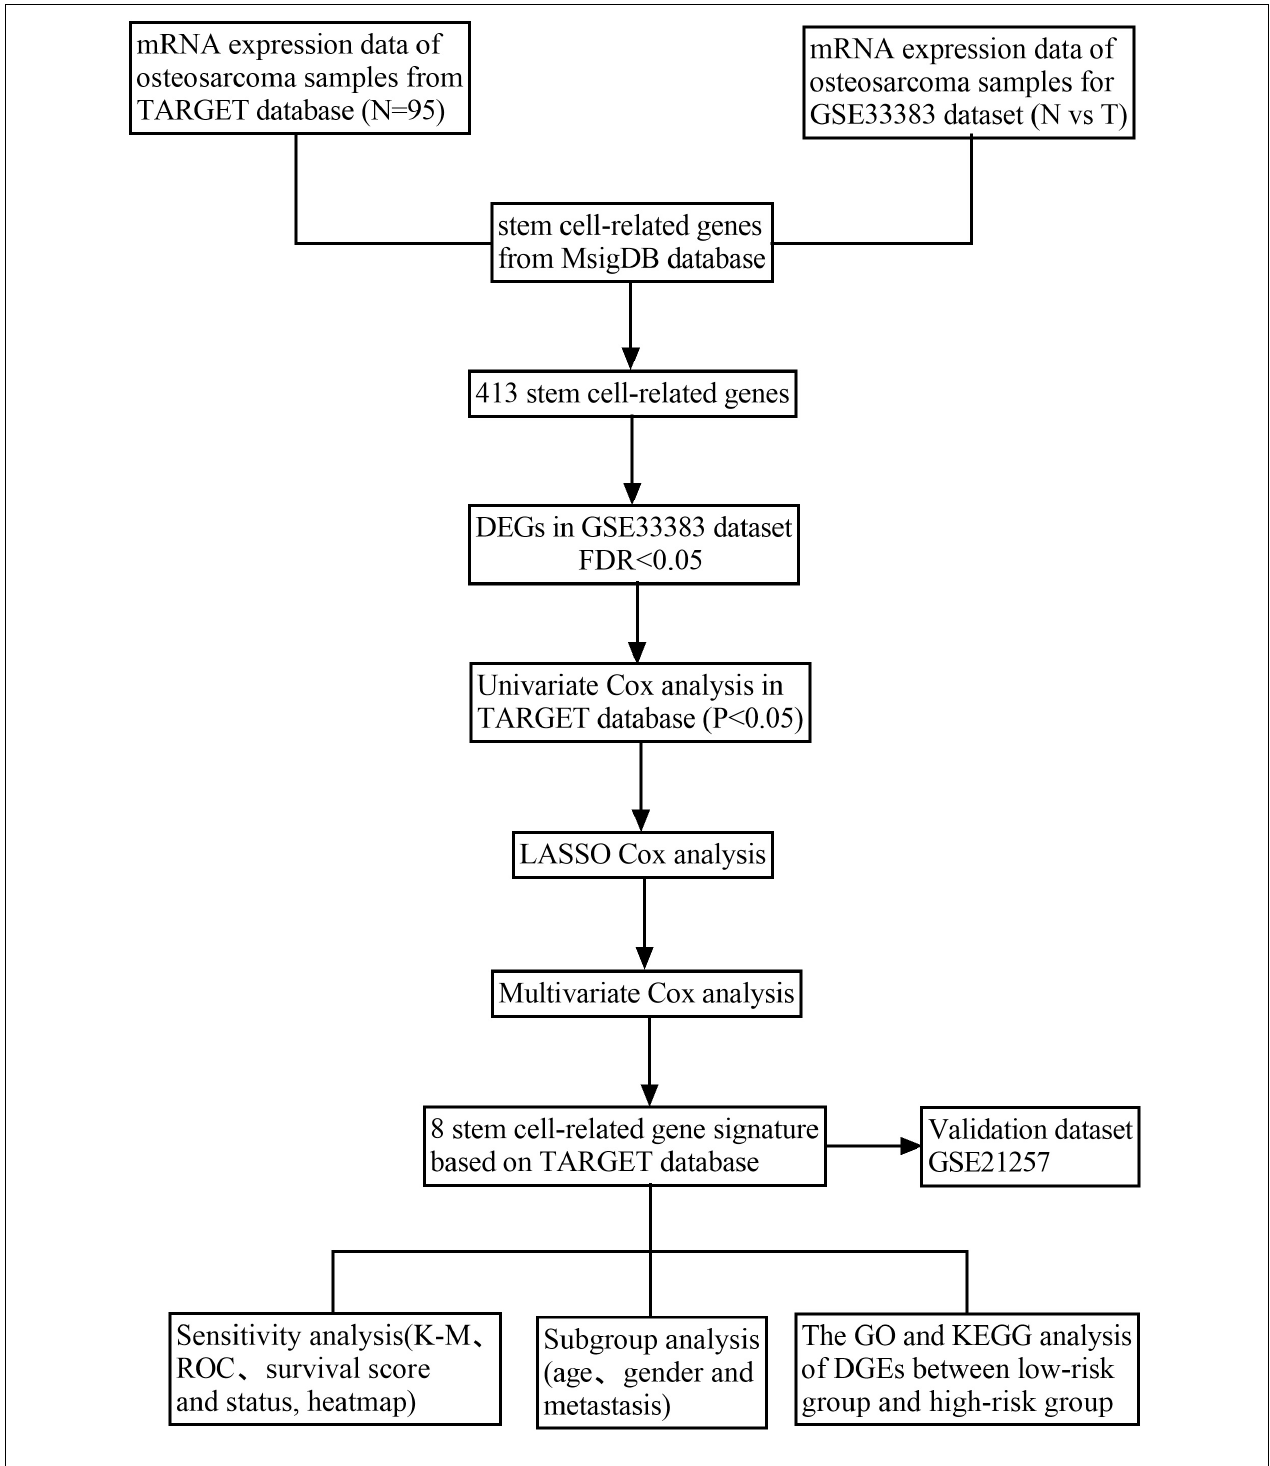
analysis. As illustrated in Figure 2C , we observed that altogether, 25 CSC-related genes correlated with the overall survival of osteosarcoma ( p < 0.05). Hence, the 25 genes were prognostic